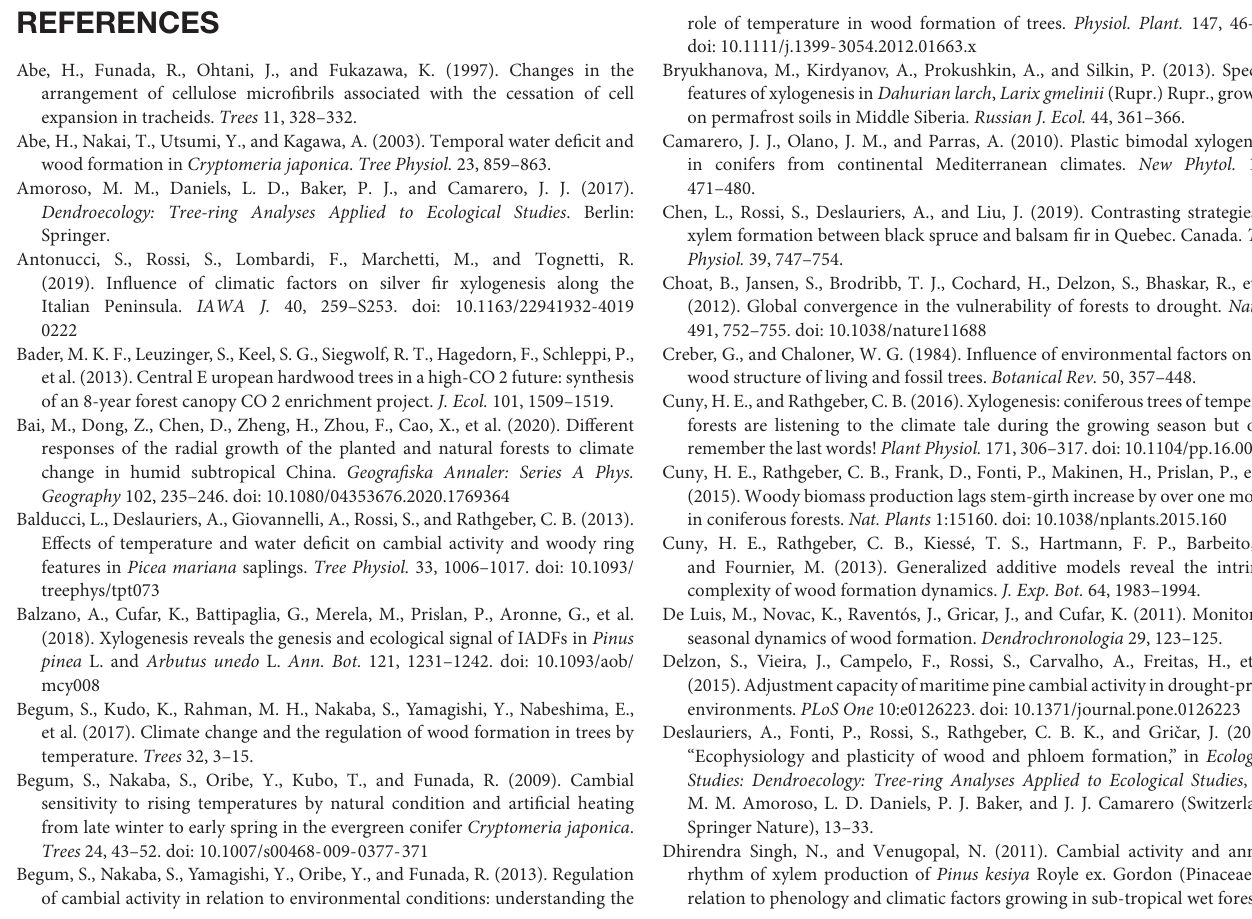
Supplementary Figure 1 | Distribution of the monthly mean temperature (symbol line) and precipitation (bar) from 1953 to 2017 from the Fuzhou meteorological station (A) . Long-term series of annual precipitation (B) , temperature (C) and their trends (dashed lines) recorded by Fuzhou meteorological station for the period of 1953–2017. Supplementary Figure 2 | Phases of cambial phenology in Cryptomeria fortunei (A–D) on DOY 119 (April 29) and Cunninghamia lanceolata (E,F) on DOY 141 (May 21) in 2017. Observed under a bright field (A,B,E) and polarized light (C,D,F) , respectively. CZ, cambium zone; EC, enlarging cells; WT, wall thickenings; MC, mature cells. Supplementary Figure 3 | Relationships between the growth rate and associated climatic factors. Significant correlations of p < 0.05 ( ∗ ), p < 0.01 ( ∗∗ ) are displayed. Supplementary Figure 4 | Relationships between duration of xylogenesis and associated climatic factors. Significant correlations of p < 0.05 ( ∗ ), p < 0.01 ( ∗∗ ) are displayed. Supplementary Figure 5 | Percentage of net cell increment to the total xylem cells in spring and summer of (A) Cryptomeria fortunei and (B)